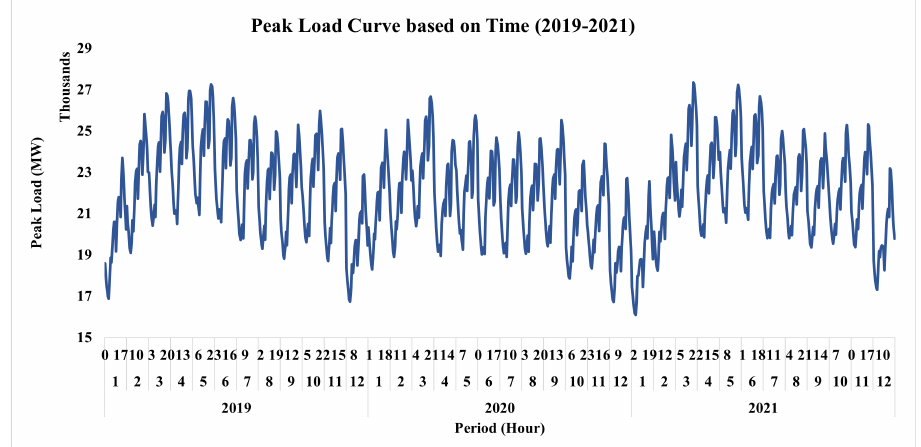
Figure 3. Variation in peak load based on time of the day (hourly) from 2019 to